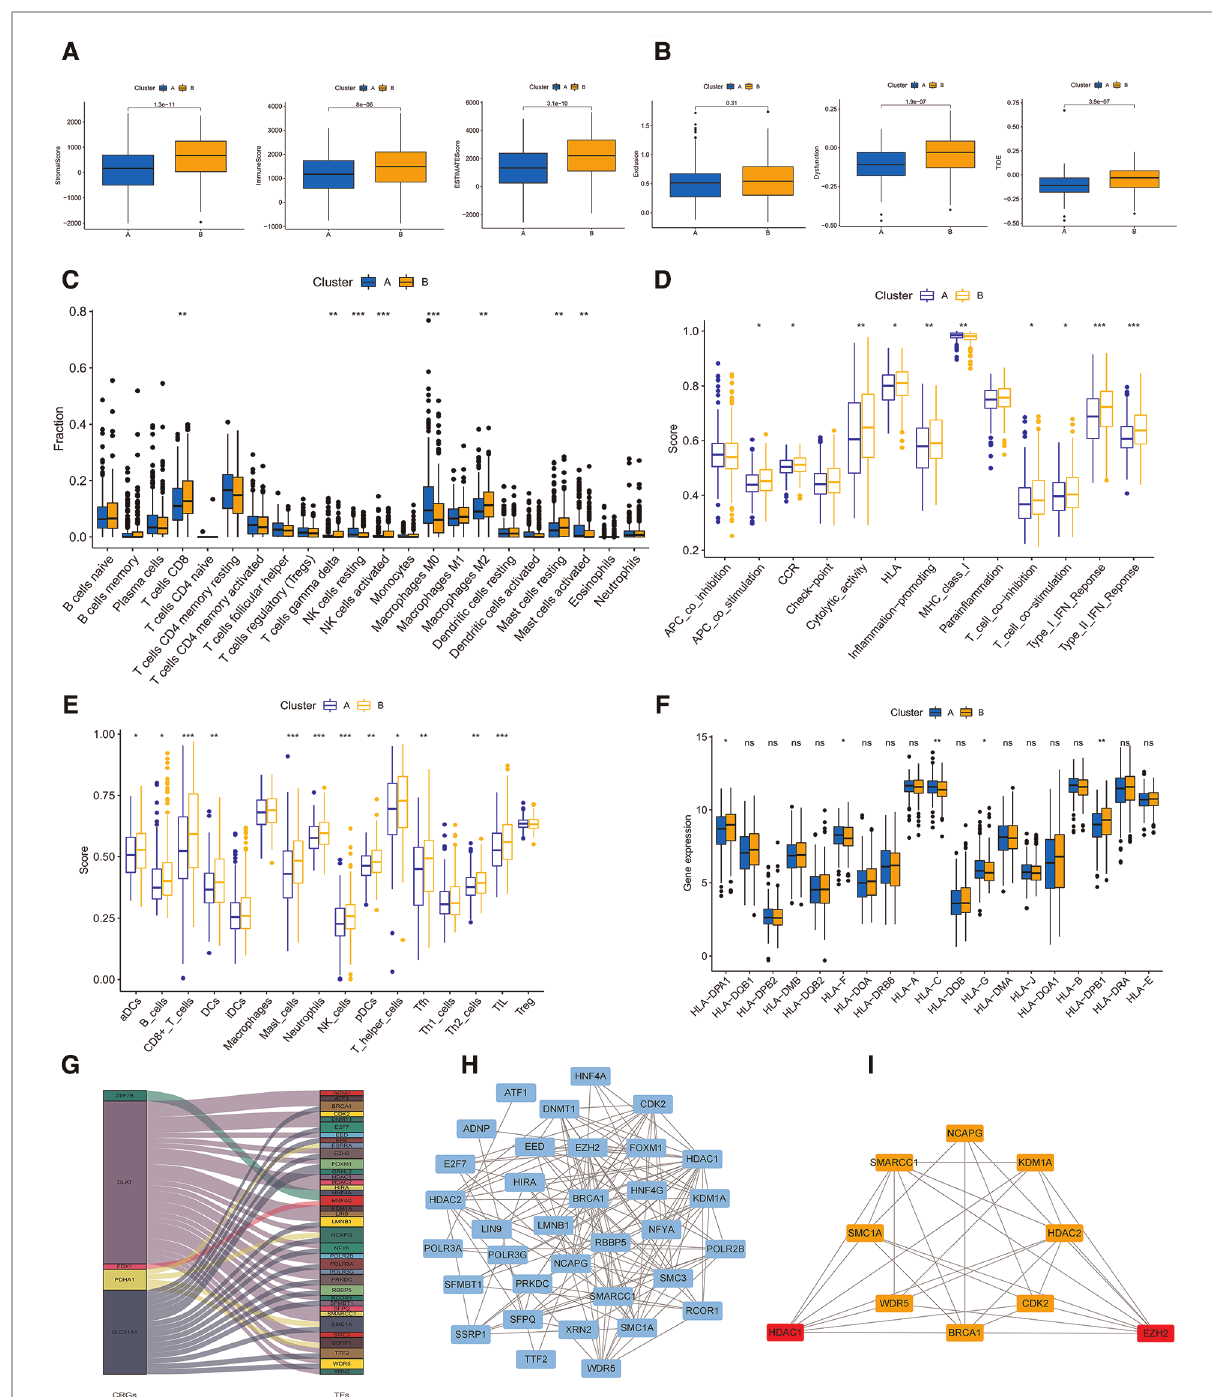
FIGURE 4 ( A ) The stromal, immune, ESTMATE scores of A and B subtypes using ESTMATE algorithm. ( B ) Associations of the TIDE score and the two subtypes. ( C ) TME cells in fi ltration in A and B subtypes by CIBERSORT algorithm. (D,E ) ssGSEA algorithm calculating the scores of immune cells in fi ltration in the two clusters. ( F ) The plot showing the expression of HLAs in the two clusters. ( G ) Sankey diagram of CRGs and transcription factors. ( H ) PPI network of the CRGs based on the STRING database. ( I ) The plot of hub transcription factors visualized by Cytoscape. GSVA, gene set variation analysis; TIDE, Tumour Immune Dysfunction and Exclusion; HLAs, human leukocyte antigens; TME, tumor microenvironment. (* P <0.05; ** P <0.01; *** P <0.001; ns, not signi fi